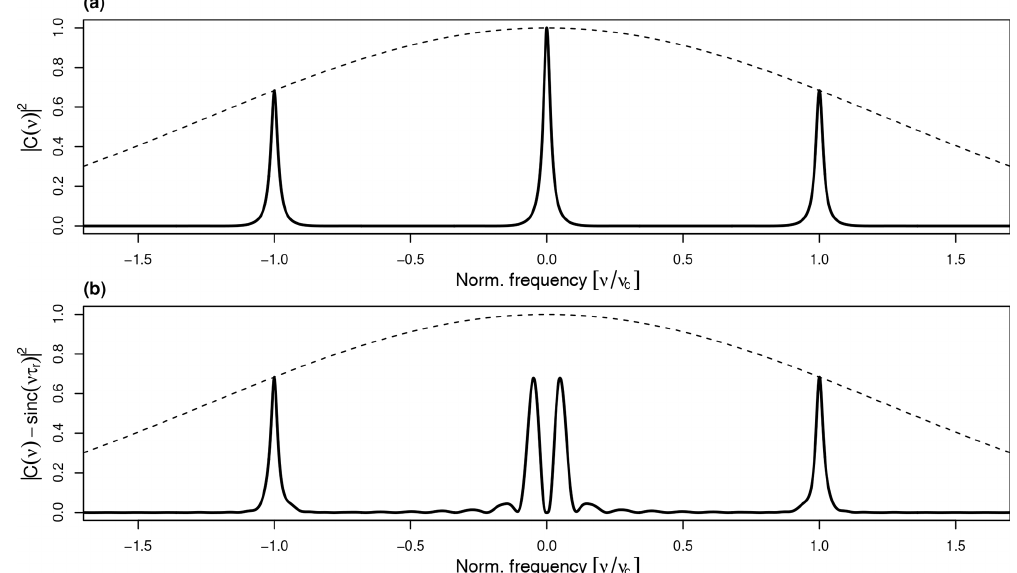
Figure 2. (a) Squared modulus of the characteristic function (or of the Fourier transform) of the jitter PDF, | C ( ν ) | 2 , given by Eq. (42) (solid line), for the same parameters as used in Fig. 1 (i.e., τ b = 10 years, τ s = 5 years, τ p = 1 / 3 year) and the envelope function sinc 2 ( ντ p ) (dashed line). (b) Squared modulus of the error transfer function, | C ( ν ) − sinc( ντ r ) | 2 , as it appears in Eq. (58) and with τ r = 9 years (dashed line as in a ). The frequency axis is normalized by the seasonal cycle frequency ν c = (1yr) − 1 .